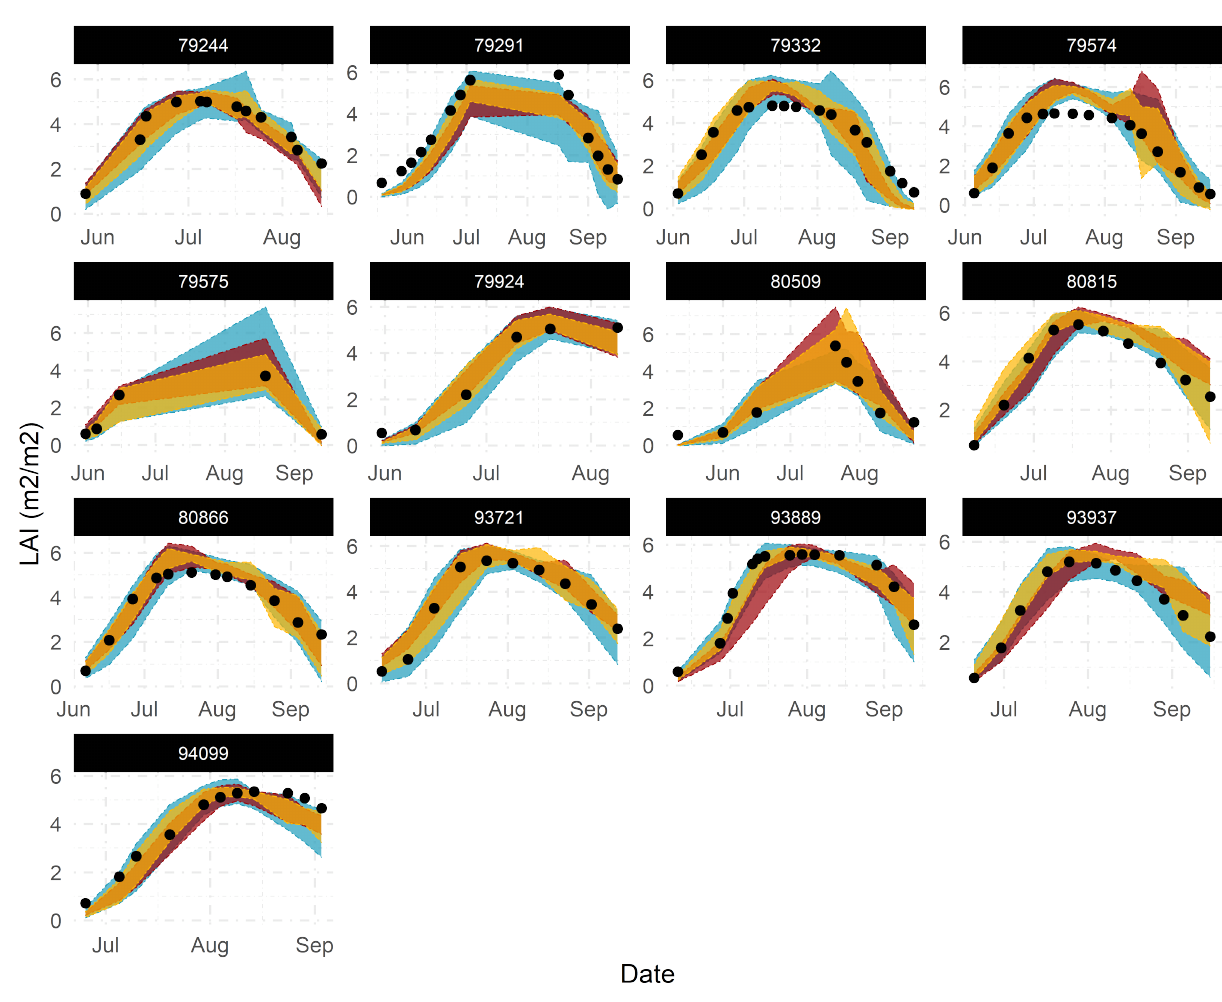
Figure 6. 95% confidence interval for emulator predicted LAI using optimized parameters corre- sponding to each optimization scheme across all calibration sites.Title for each subplot corresponds to the site ID in Beck’s dataset. Table 2. Performance of different optimization schemes across different months for